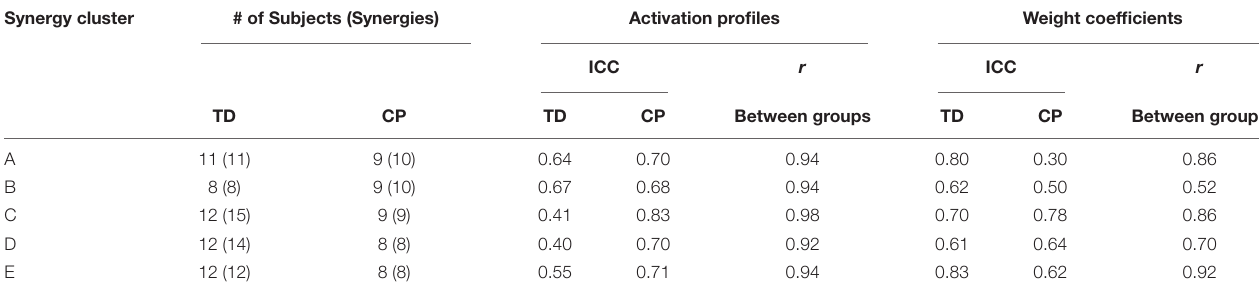
TABLE 5 | Synergy structure characteristics. Synergy cluster # of Subjects